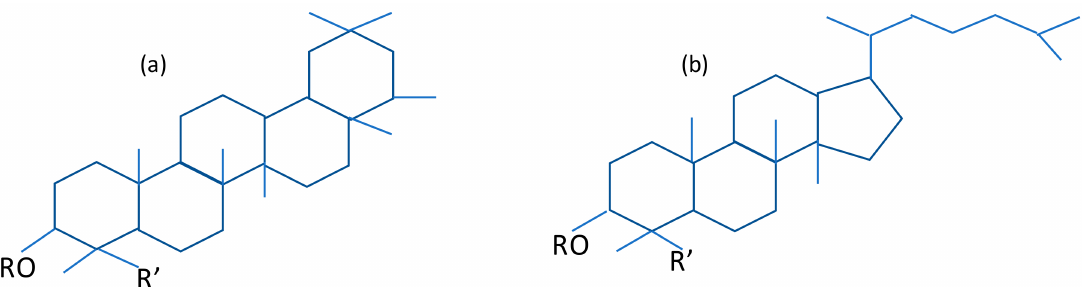
Figure 2. Saponin structure: ( a ) Triterpenoid type; and ( b ) Steroid